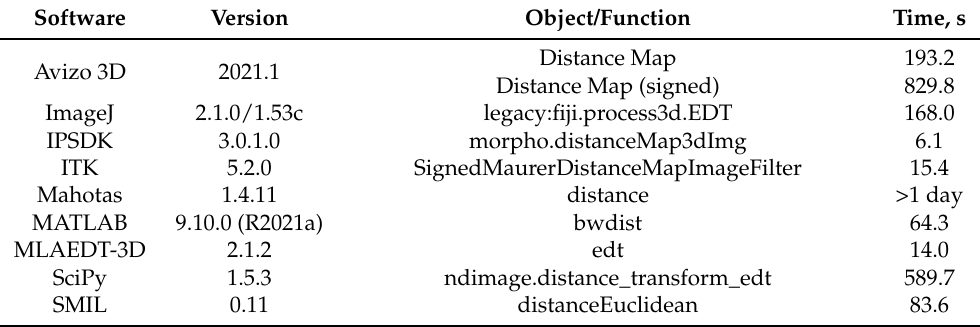
Table 5. Processing time of 3D Euclidean distance transform